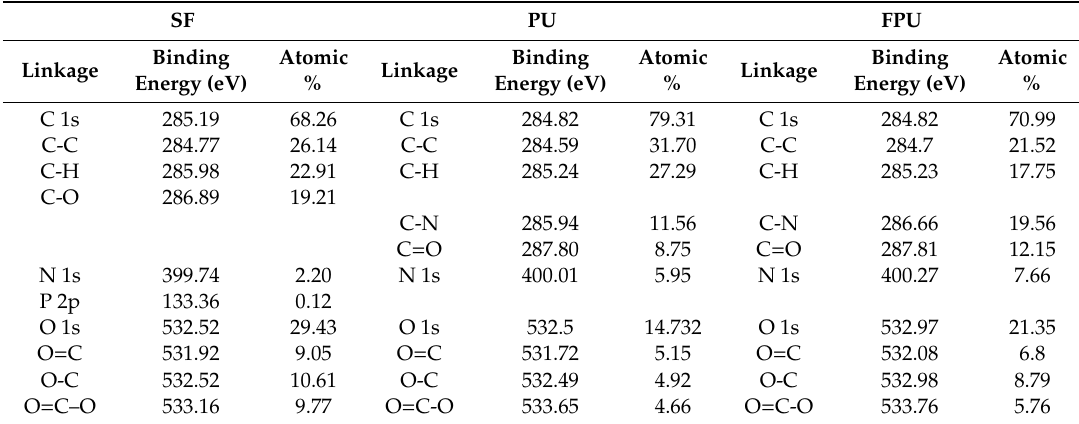
Figure 4. Survey XPS ( A – C ), multiplex scans of carbon 1s region ( D – F ) and multiplex scans of oxygen 1s region ( G – I ) of SF, PU and FPU coatings. Table 5. XPS analysis of SF, PU and FPU